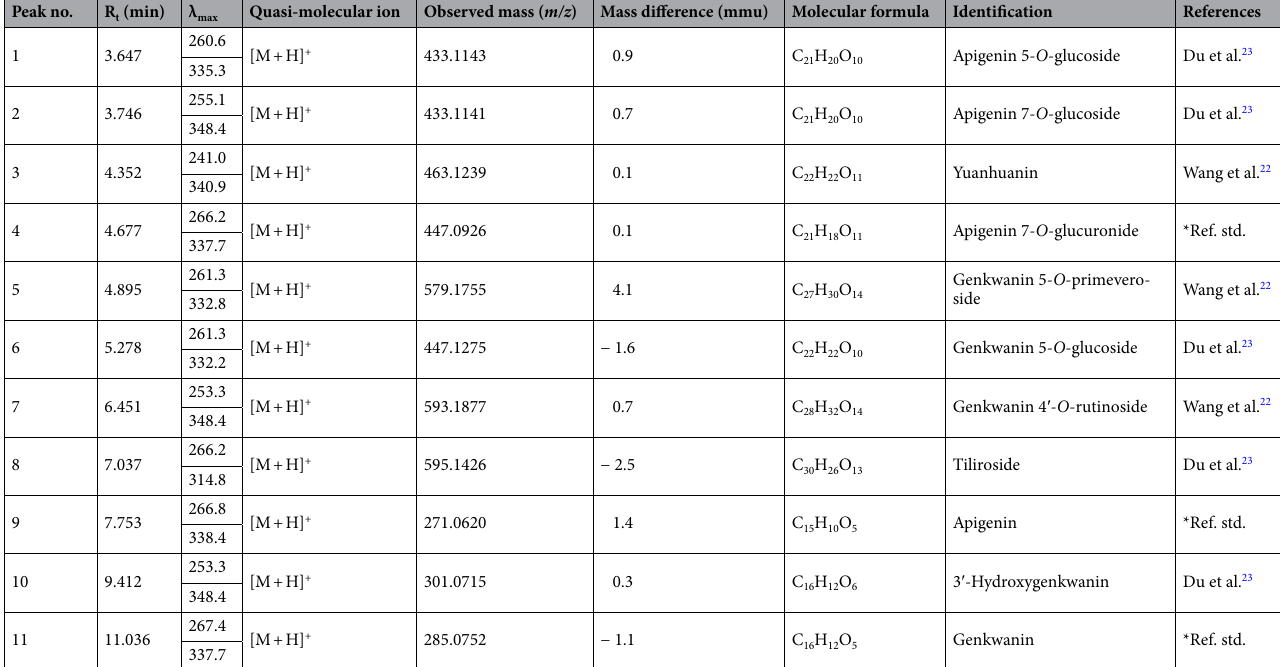
Table 1. The retention time, λ max, quasi-molecular ion, observed mass, mass difference, and molecular formulae of eleven peaks by UPLC-PDA-ESI/MS analysis. *Ref.std.; comparison with those reference standard solutions by UHPLC analysis. *The peak number and retention time information are tagged on representative chromatogram in Fig.